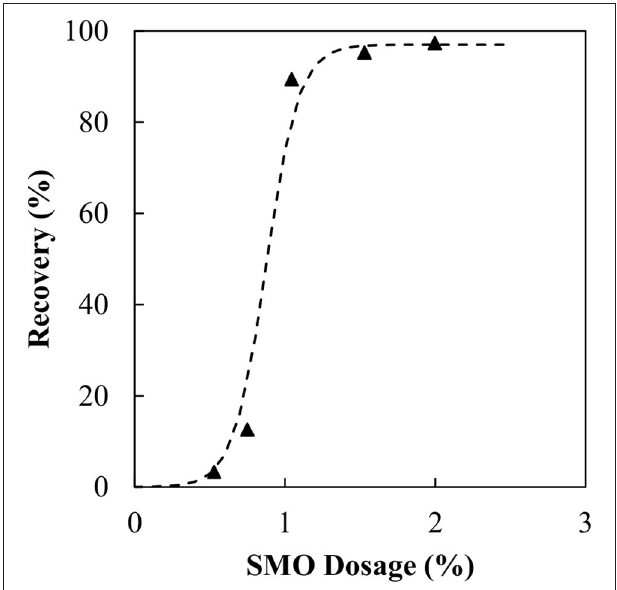
FIGURE 4 | Magnetite recovery as a function of SMO collector concentration at predicted organic liquid dosage.